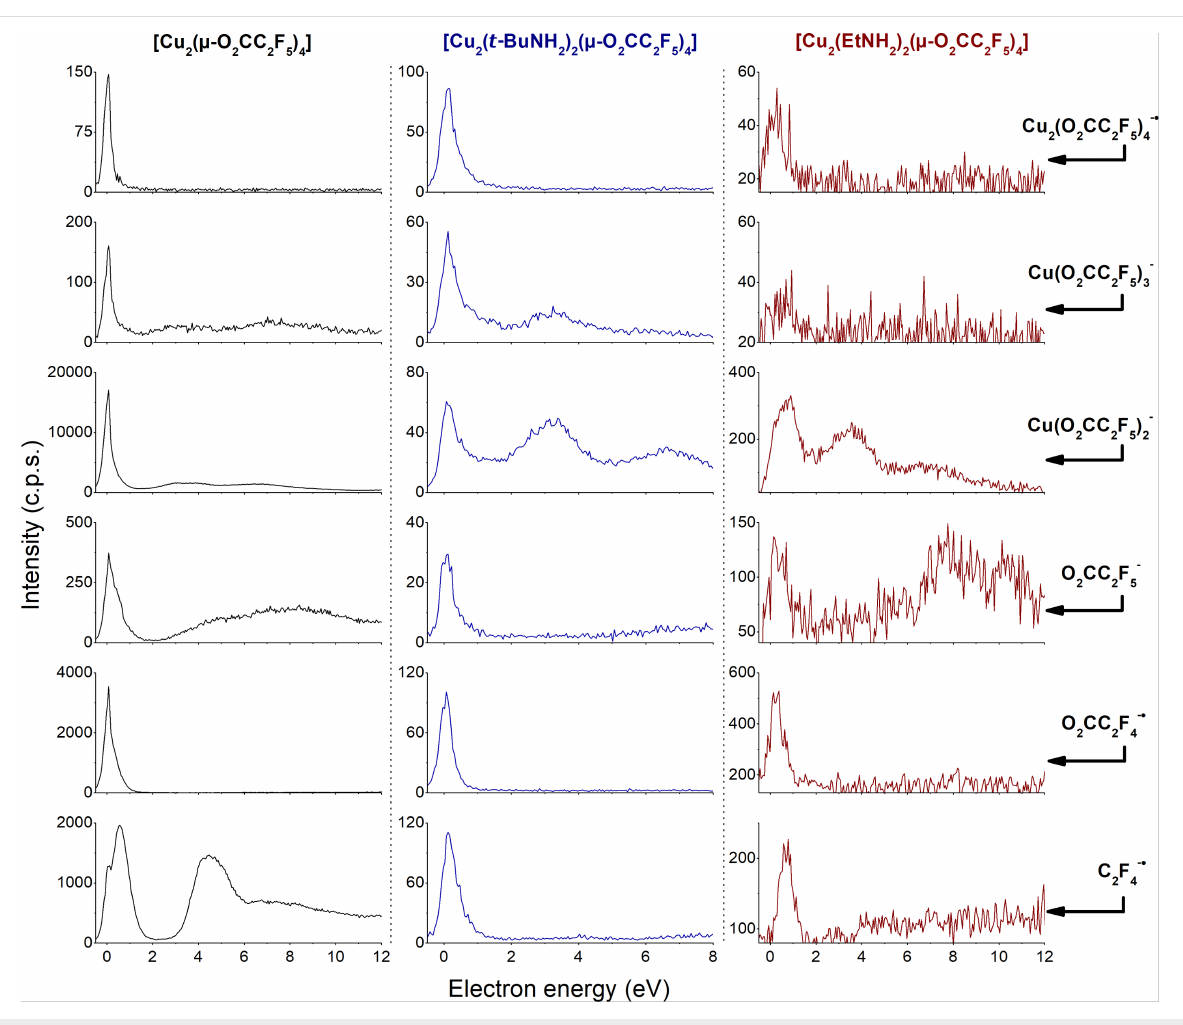
Figure 8: Relative ion yields of negative products from [Cu 2 (µ-O 2 CC 2 F 5 ) 4 ] (left column), [Cu 2 ( t -BuNH 2 ) 2 (µ-O 2 CC 2 F 5 ) 4 ] (middle column) and [Cu 2 (EtNH 2 ) 2 (µ-O 2 CC 2 F 5 ) 4 ] (right column) as function of electron energy. Each row represents the negative ion shown on the right. The energy scale was calibrated with respect to the formation of SF 6 − by electron attachment to SF 6 that occurs at an electron energy ≈ 0